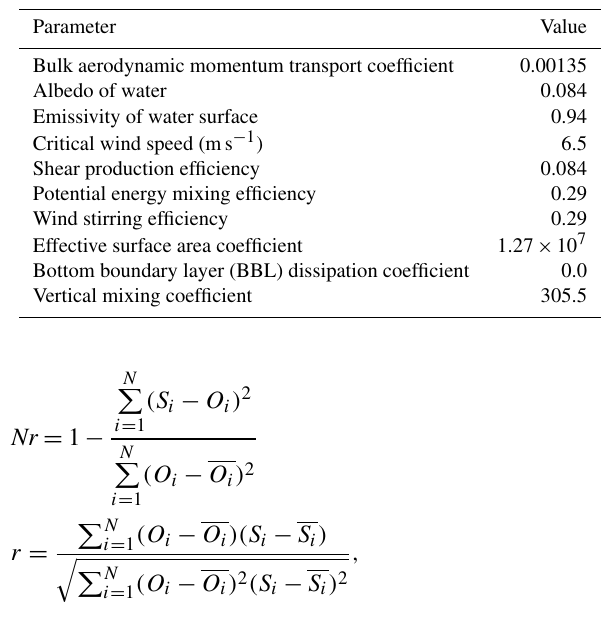
Table 1. Selected physical parameters used in DYRESM based on autocalibration from 10000